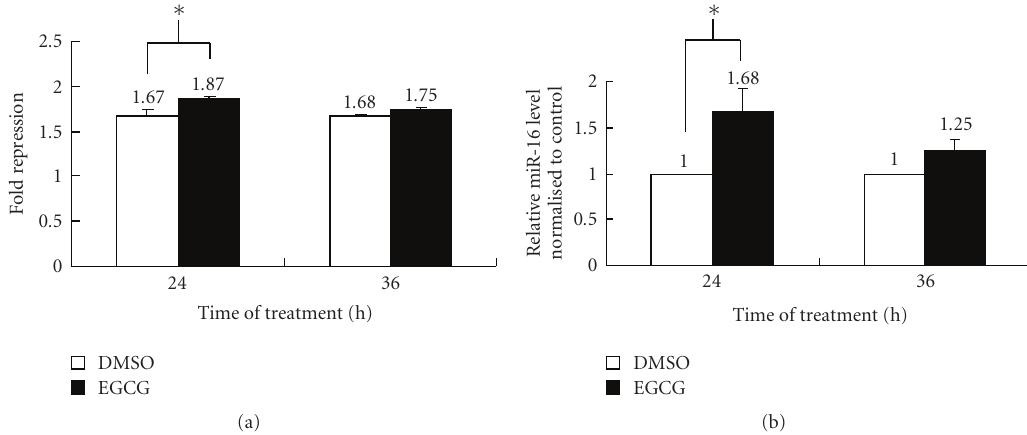
Figure 3: Increase in miR-16 activity after EGCG treatment of HepG2 cells. HepG2 cells were grown in 5mL of DMEM in 6cm Petri dishes to 70% confluency. (a) The cells were cotransfected for 6 hours with 4 μ g of pMLuc or pMLuc-UTR and 4 μ g of pSEAP2-Control, then 5 μ L of 100 mM of EGCG (dissolved in DMSO) or DMSO was added. The medium was replaced with fresh medium at 24 and 36 hours and an aliquot of medium was withdrawn 2 hours later and assayed for MLuc and SEAP. The fold repression is defined as the MLuc (from pMLuc)/SEAP ratio divided by the MLuc (from pMLuc-UTR)/SEAP ratio. (b) The cells were treated with or without EGCG for 24 or 36 hours, then total RNA was extracted and subjected to qRT-PCR to detect levels of miR-16 and U6 small nuclear RNA (see Section 2 for details). The data presented are the mea n ± SD of triplicates; ∗ P < . 05